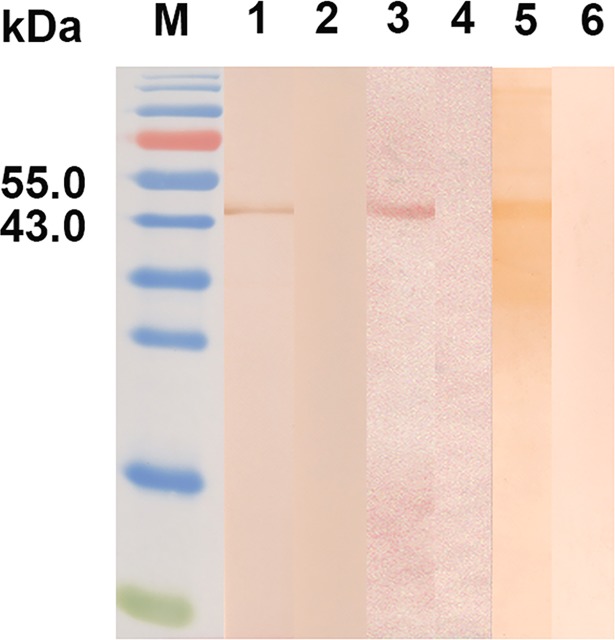
Western blotting of recombinant and native Cs1.Blots were probed with anti-rCs1 monoclonal antibody (Lanes 1, 3, and 5) or S/P20 (Lanes 2, 4, and 6). Lanes 1 and 2, rCs1; Lanes 3 and 4, C. sinensis ESPs; Lanes 5 and 6, crude antigens of adult C. sinensis. M, protein molecular weight marker.